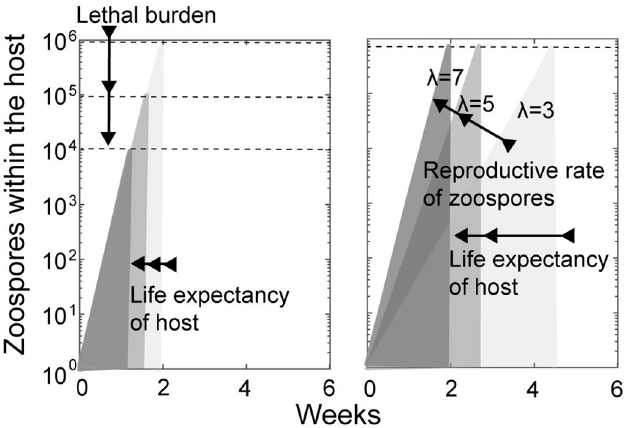
Fig 5. Relationship between zoospore lethal burden, reproductive rate and the life expectancy of host ( λ ). The dashed line identifies the zoospore concentration for which host survival is zero. The vertical projections of the intercept of the number of zoospores with the lethal zoospore load indicates the life expectancy of the host for each value of λ .